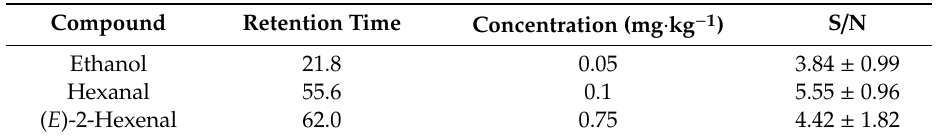
Table 2. Concentration (mg · kg − 1 ) of each compound included in the standard solution used for method’s sensitivity evaluation and related S / N. The standard mix were prepared by spiking refined olive oil with each compound and analysed by flash gas chromatography (FGC). S = intensity of the peak of the compound; N = mean intensity of the noise measured considering the baseline of the chromatographic zone between 43 and 50